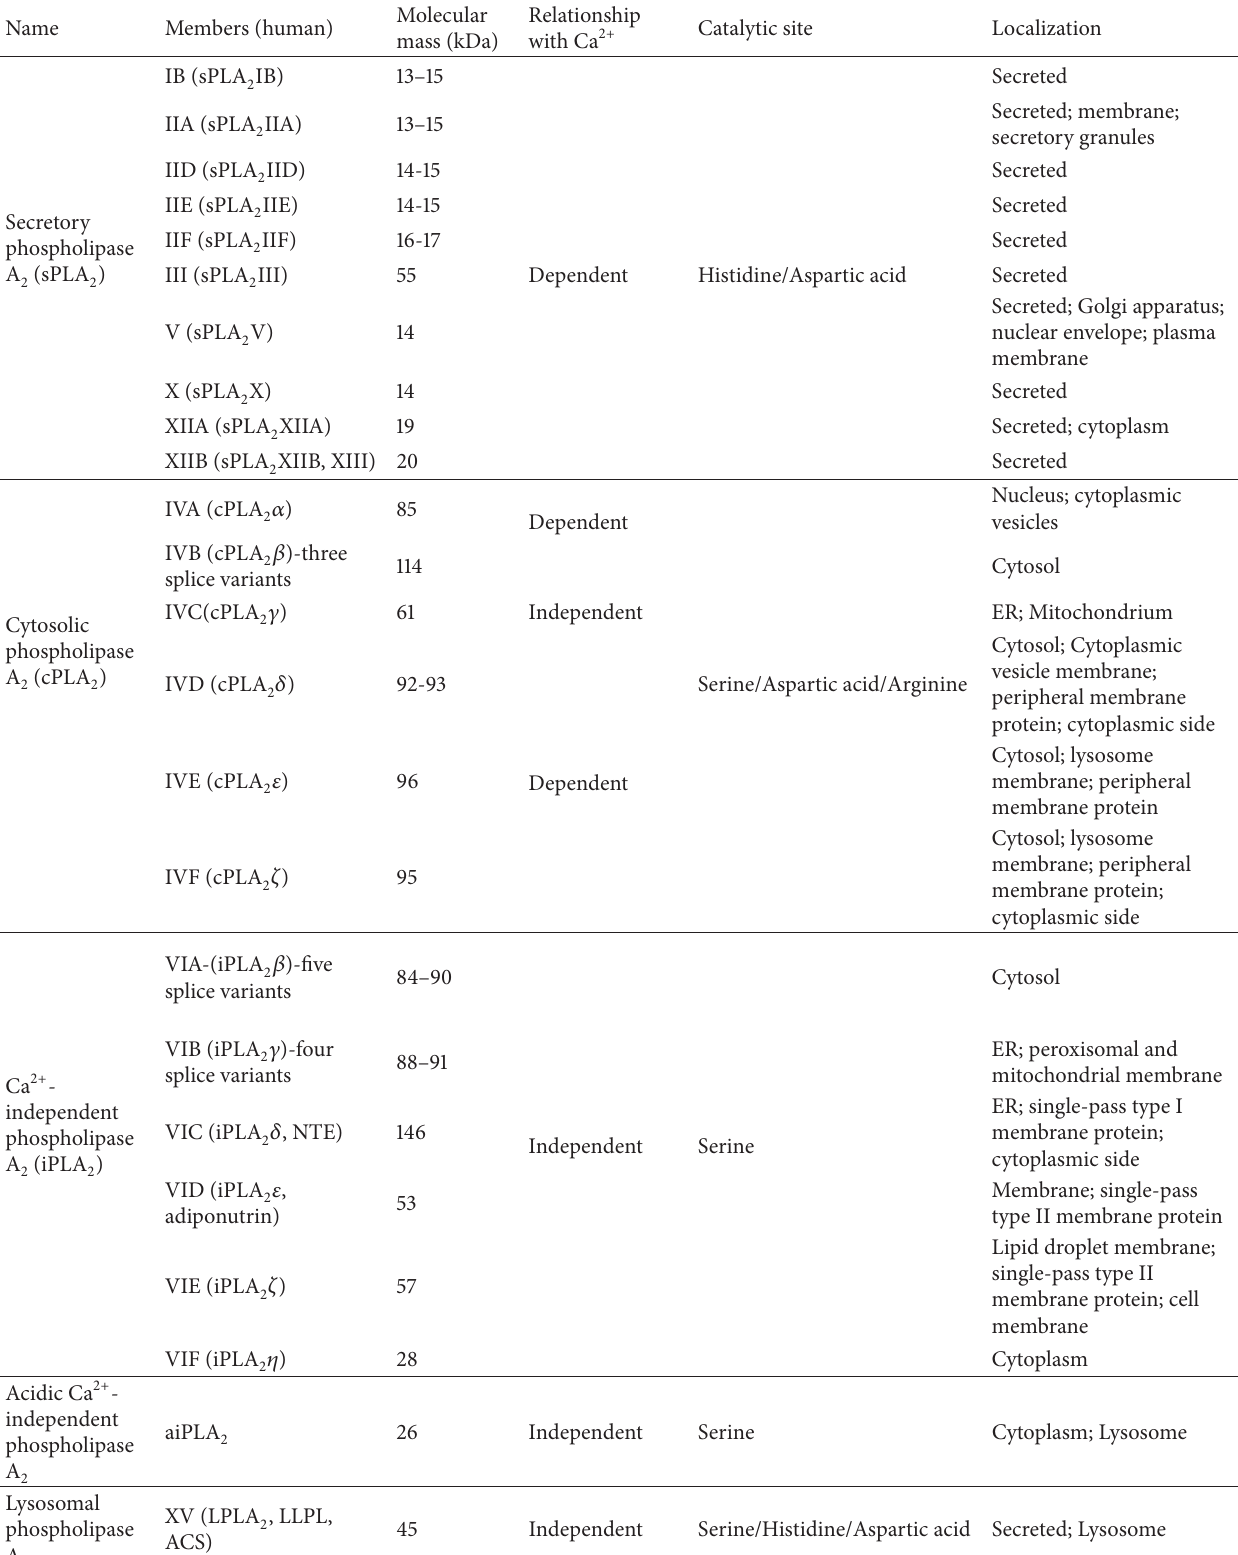
Table 1: Characteristics of structure and localization of human phospholipase A numeral indicates the group, and the capital letter after the number indicates the